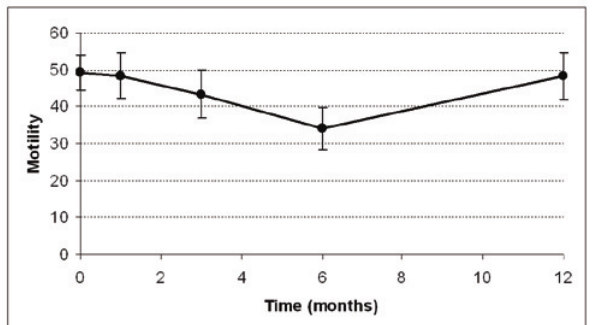
Figure 2 - Variation of sperm Motility over